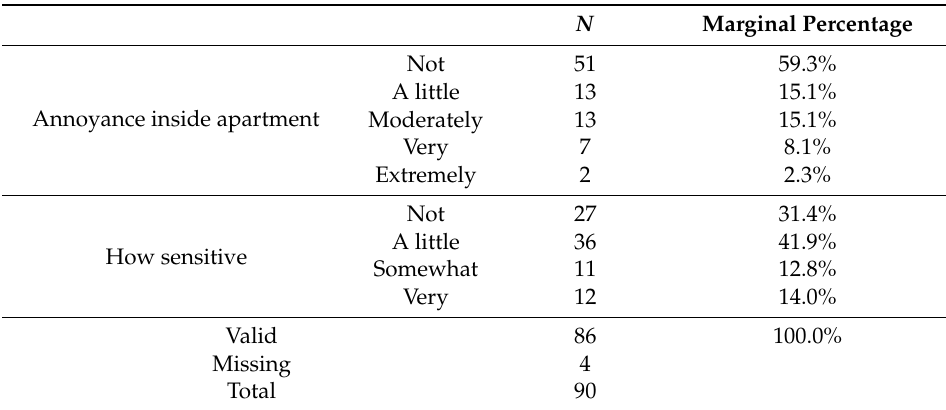
Table A3b. Case Processing Summary.